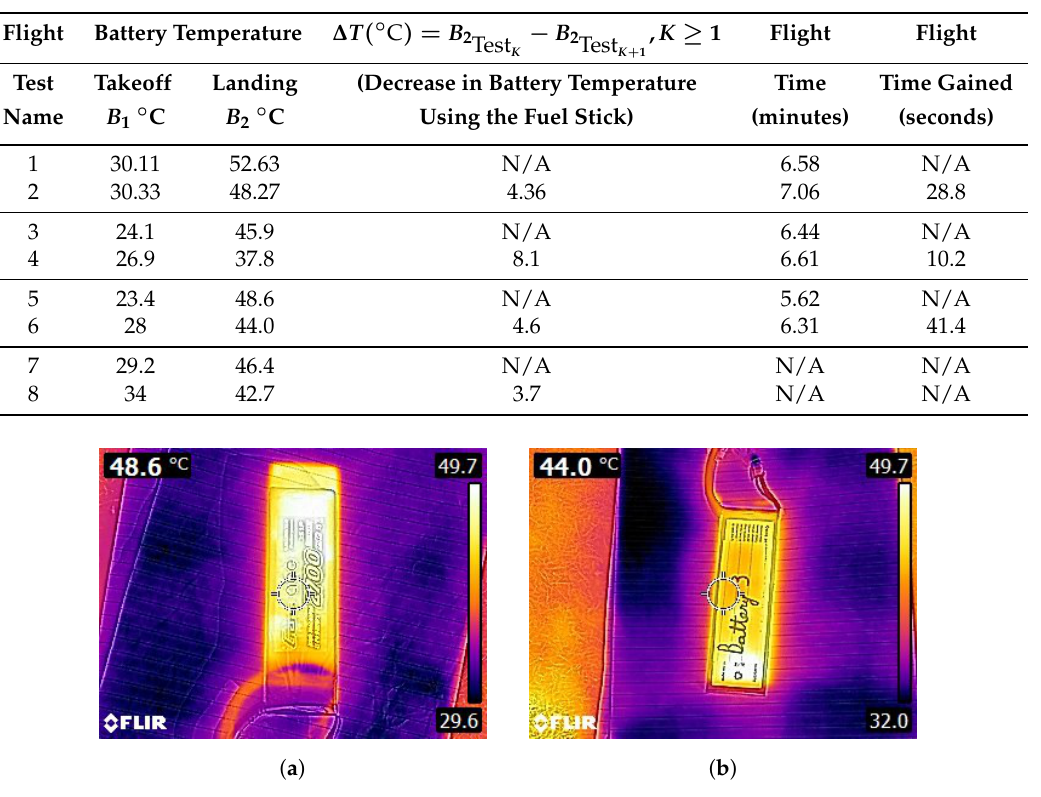
Figure 13. ( a ) Flight test 5—temperature of battery without fuel stick-based cooling; ( b ) Flight test 6—temperature of battery with fuel stick-based cooling. Flight tests 5 and 6—decrease in battery temperature via fuel stick-based cooling. Images captured by thermal imaging device